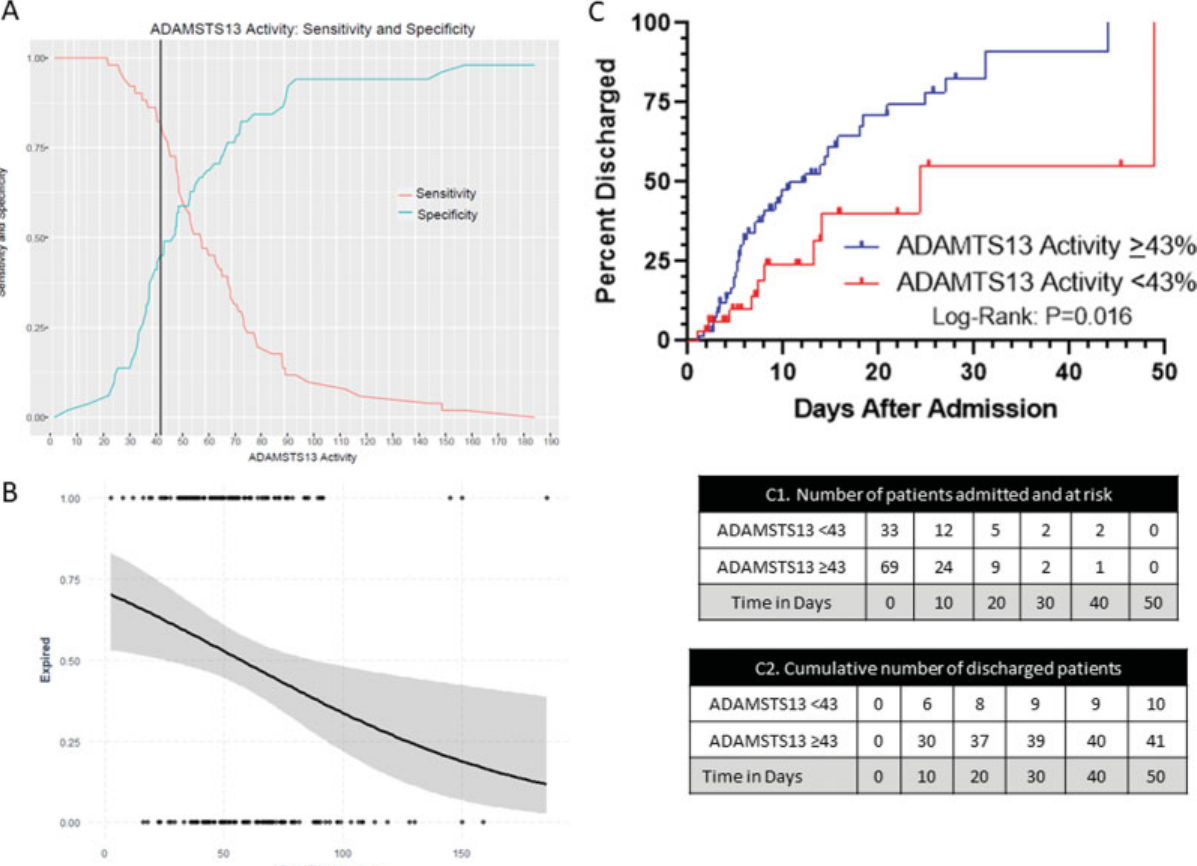
Fig. 3 Initial ADAMTS13 activity as a predictor of mortality. ( A ) Youden index measuring the optimal cut point for ADAMTS13 activity as a differentiating marker when equal weight is given to sensitivity and speci fi city for the values in the cohort. The optimal cut-point for the initial ADAMTS13 activity within 72hours since admission to predict mortality was found to be at 43% with an accuracy of 0.63, sensitivity of 0.82, and AUC of 0.63. ( B ) Logistic regression model of initial ADAMTS13 activity adjusted by age. Patients that deceased (each dot at the top classi fi ed as event 1) presented with lower ADAMTS13 activity levels compared to patients that were discharged alive (each dot at the bottom classi fi ed as event 0). The gray zone represents 95% of the con fi dence interval. ( C ) Kaplan-Meier curve shows cumulative number of discharged COVID-19 positive patients over time ( n ¼ 102) based on initial ADAMTS13 activity. Patients with ADAMTS13 activity (cid:5) 43 show higher rate of discharge alive compared to patients with ADAMTS13 activity < 43 (log rank, p ¼ 0.016). C1 table shows the number of COVID-19 positive patients admitted and at risk of mortality over time. C2 table shows the cumulative number of discharged alive patients in each group in increments of every 10 days. Each dot represents a discharged alive patient. ADAMTS13, a disintegrin and metalloproteinase with a thrombospondin type 1 motif, member 13; COVID-19, coronavirus disease